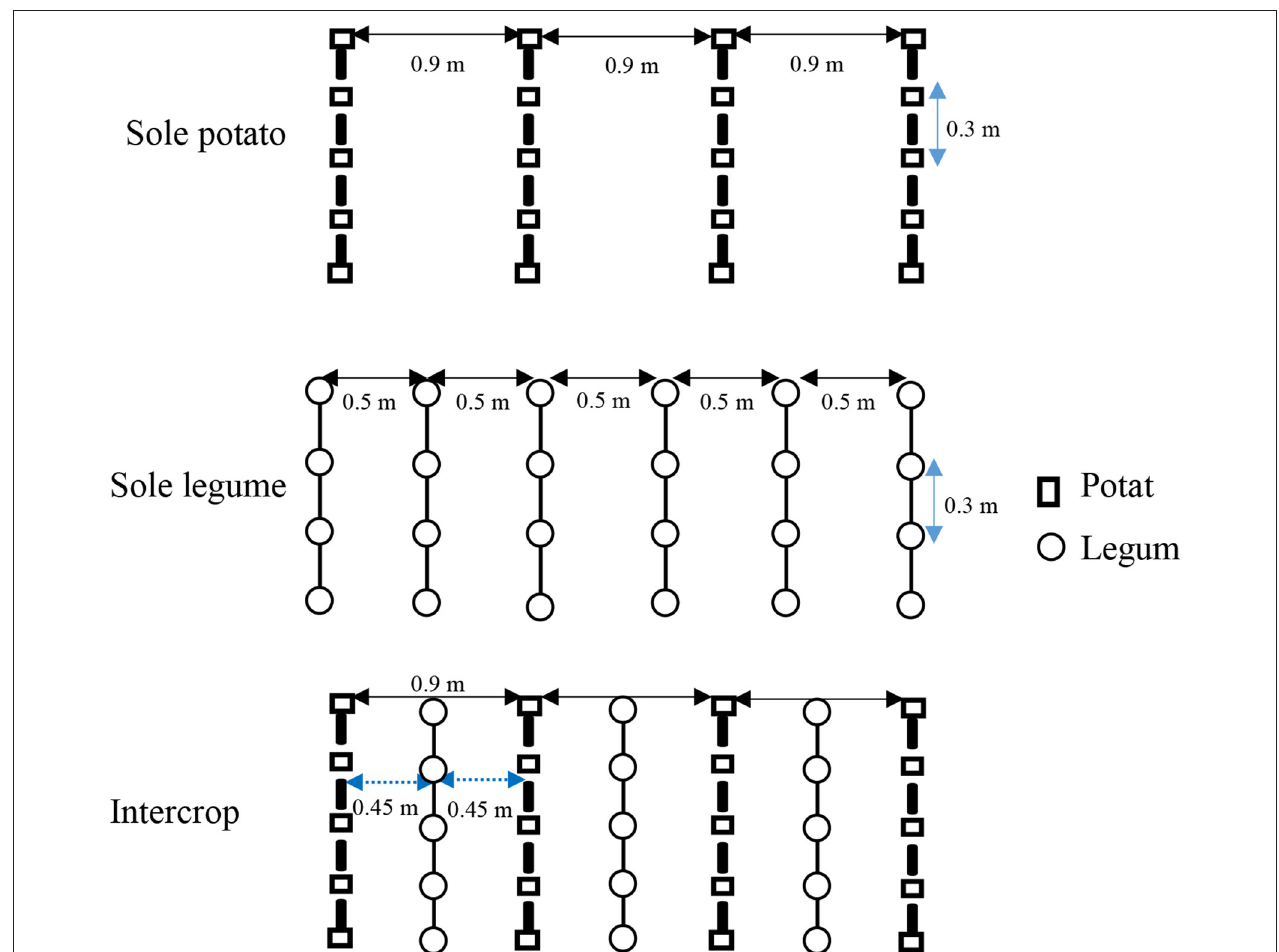
FIGURE 2 | Spacing used in treatments with potato and legumes grown singly or